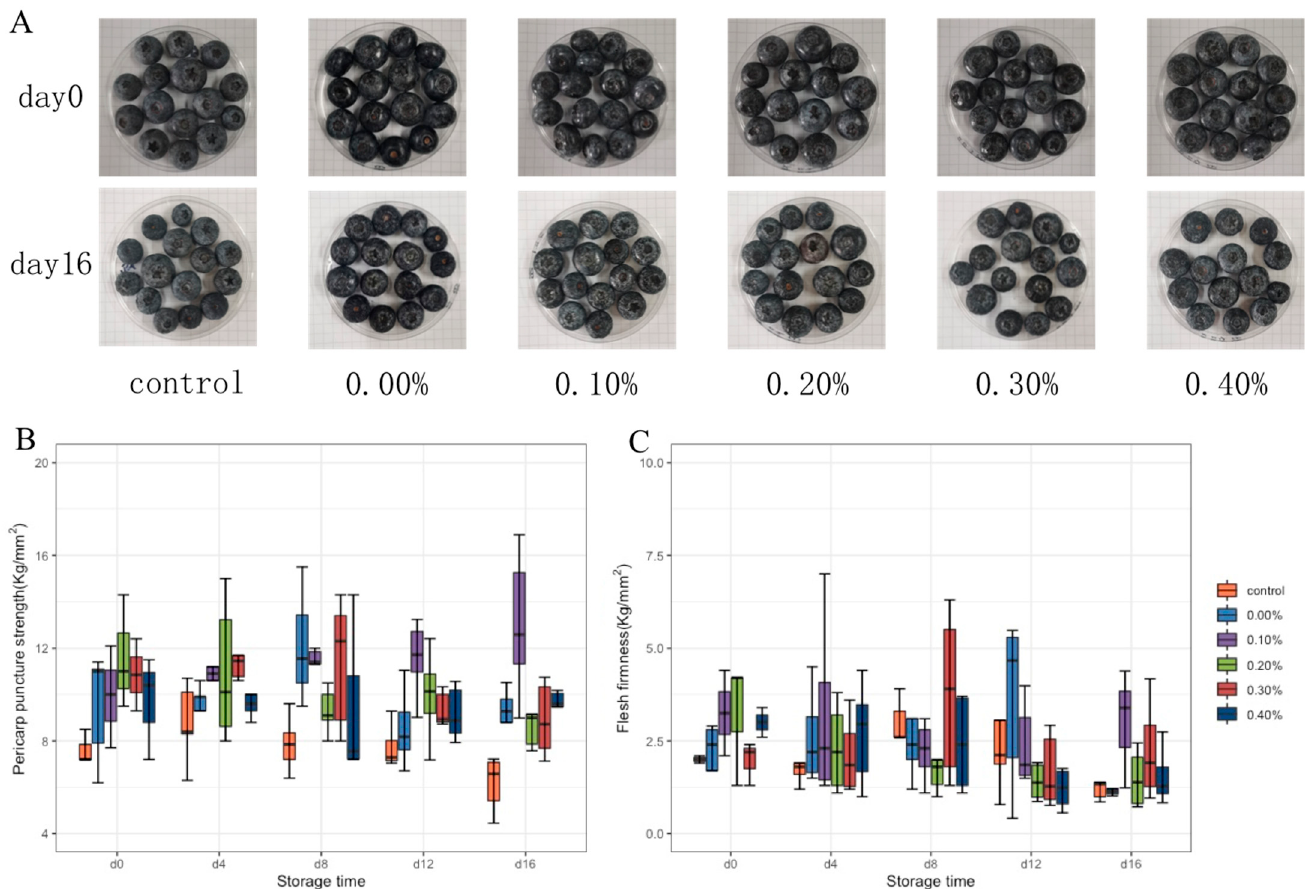
Figure 6. Photographs ( A ), pericarp puncture strength ( B ), and average flesh firmness ( C ) of blueberries during storage.